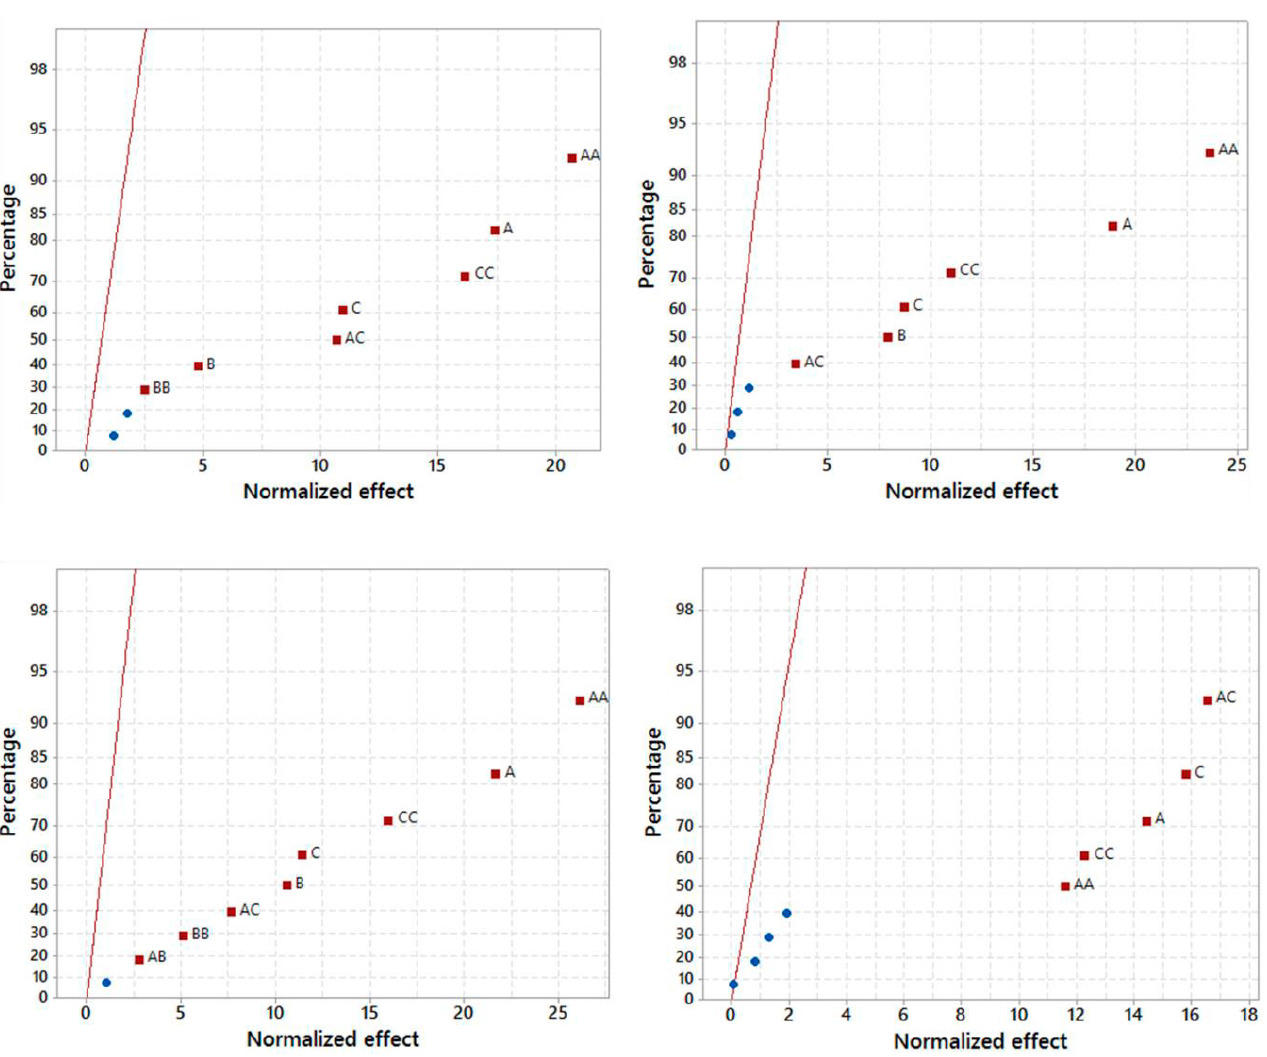
Figure 1. Henry’s half-line of the normalizing effects of the temperature, inducer concentration and induction duration, for M30, I30, B19 and A19; factors are coded as follows: temperature (A), inducer concentration (B), induction duration (C); answer = enzyme activity (U L-1of culture); α = 0.05; the adjustment line in red indicates where the points should be if there was no effect. Henry’s half-line displays the absolute value of all the normalized effects, positive and negative. All terms are on the right side of the graph, and their distance from the line highlights their relative importance; significant effects are represented by red squares ( ■ ), while non-significant effects are represented by blue circles ( ● ).